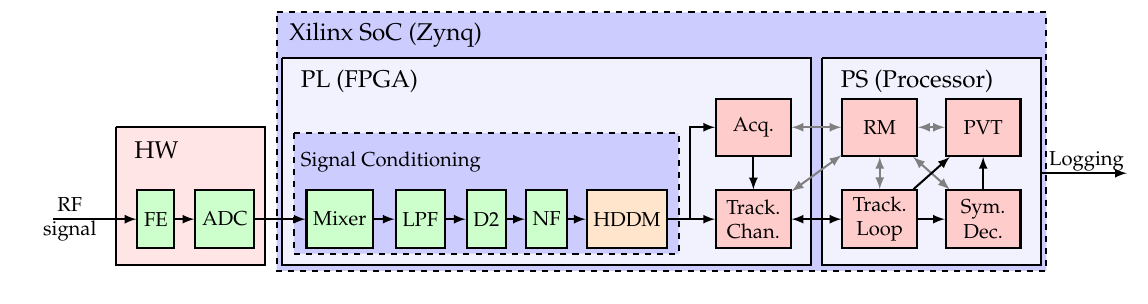
Figure 8. Hardware flow